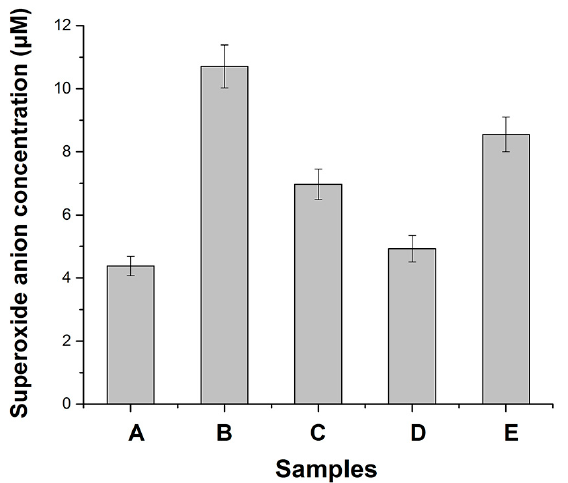
Figure 2. Inhibition of Cu 2+ or soybean trypsin inhibitor (STI) on trypsin activities of superoxide scavenging in sod mutant strain PN134. ( A ) Culture of PN134; ( B ) Culture of PN134 with 4-OH-PCB11; ( C ) Culture of PN134 with 4-OH-PCB11 plus trypsin; ( D ) Culture of PN134 with 4-OH-PCB11 plus trypsin and Cu 2+ ; ( E ) Culture of PN134 with 4-OH-PCB11 plus trypsin and inhibitor